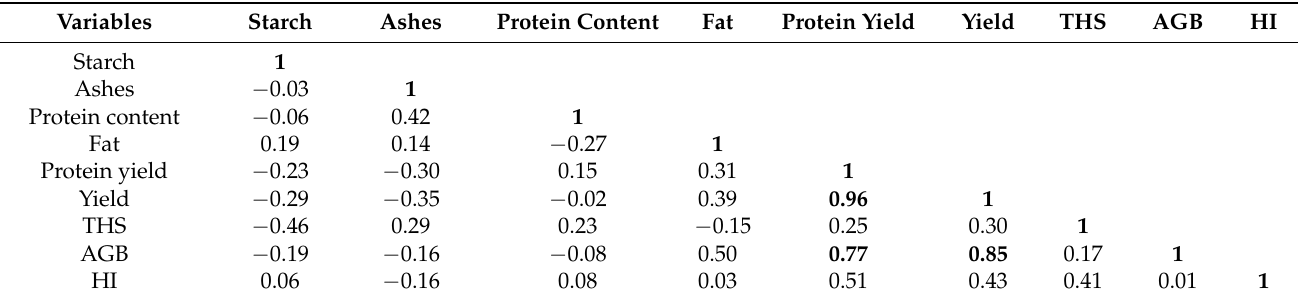
Table 4. Correlations Coefficients among Yield, Yield Components (THS, AGB, and HI), and Seed Quality (Protein content, Fat, Starch, and Ashes) Variables for 12 Kabuli Chickpea accessions during the 2017 Growing Season.